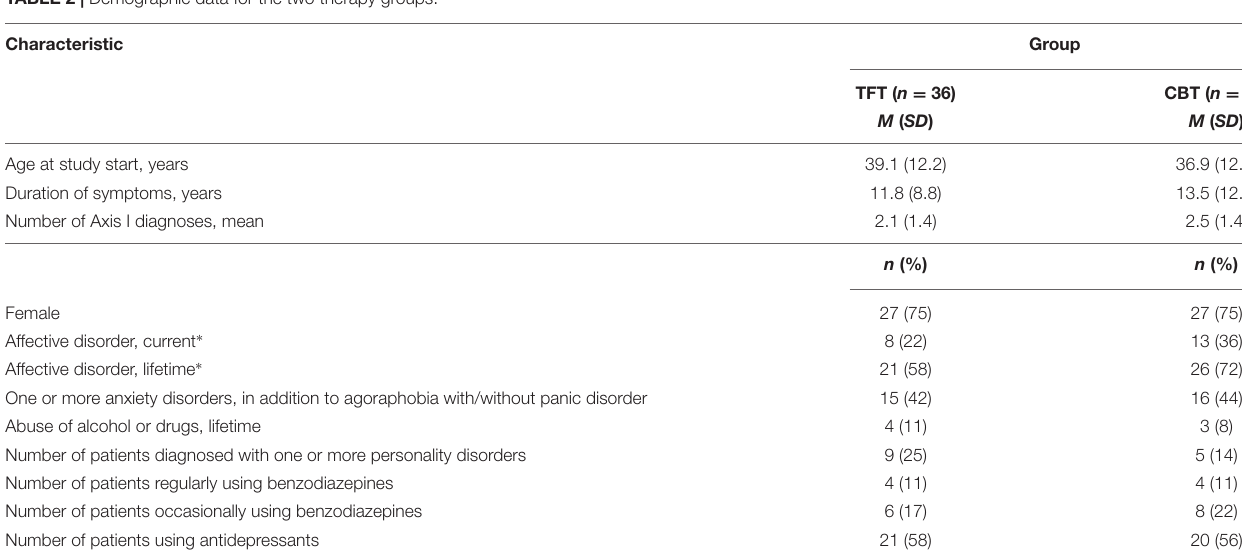
TABLE 2 | Demographic data for the two therapy